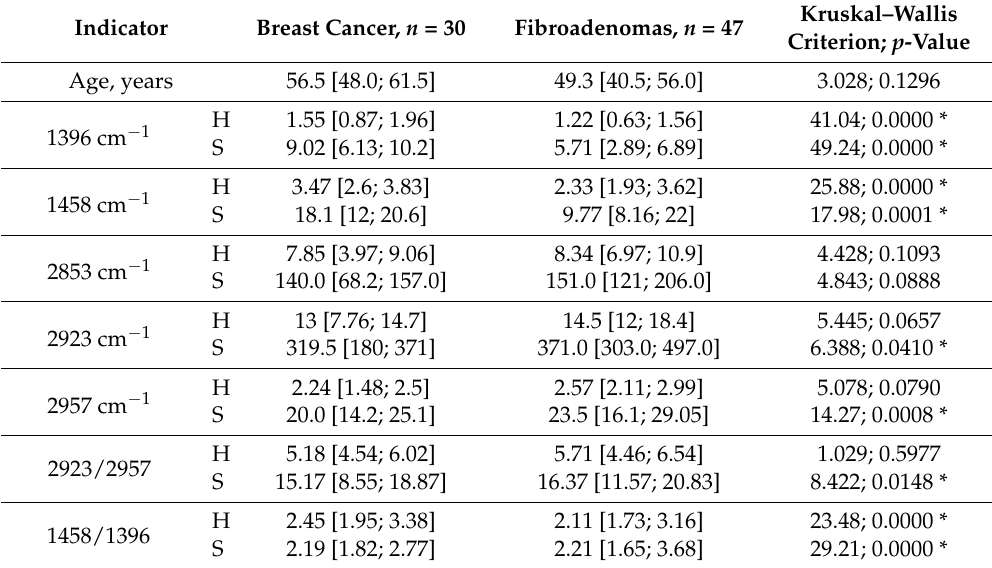
Figure 2. Scatter plot of canonical values for the control group depending on gender and age (blue circles—females under 50, red squares—females over 50, green diamonds—males under 50, pink triangles—males over 50). The ellipses mark the groups, the differences of which with others are statistically significant. Table 4. Characteristics of salivary IR spectra of patients with breast